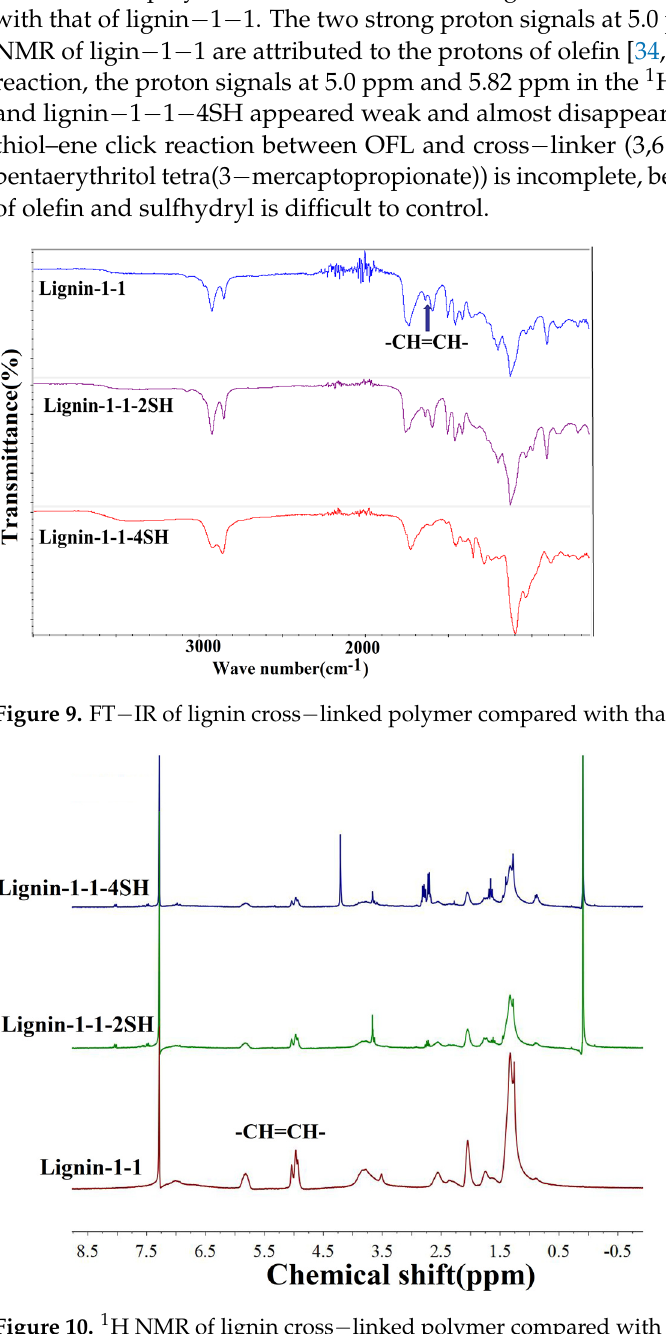
Figure 10. 1 H NMR of lignin cross − linked polymer compared with that of lignin.